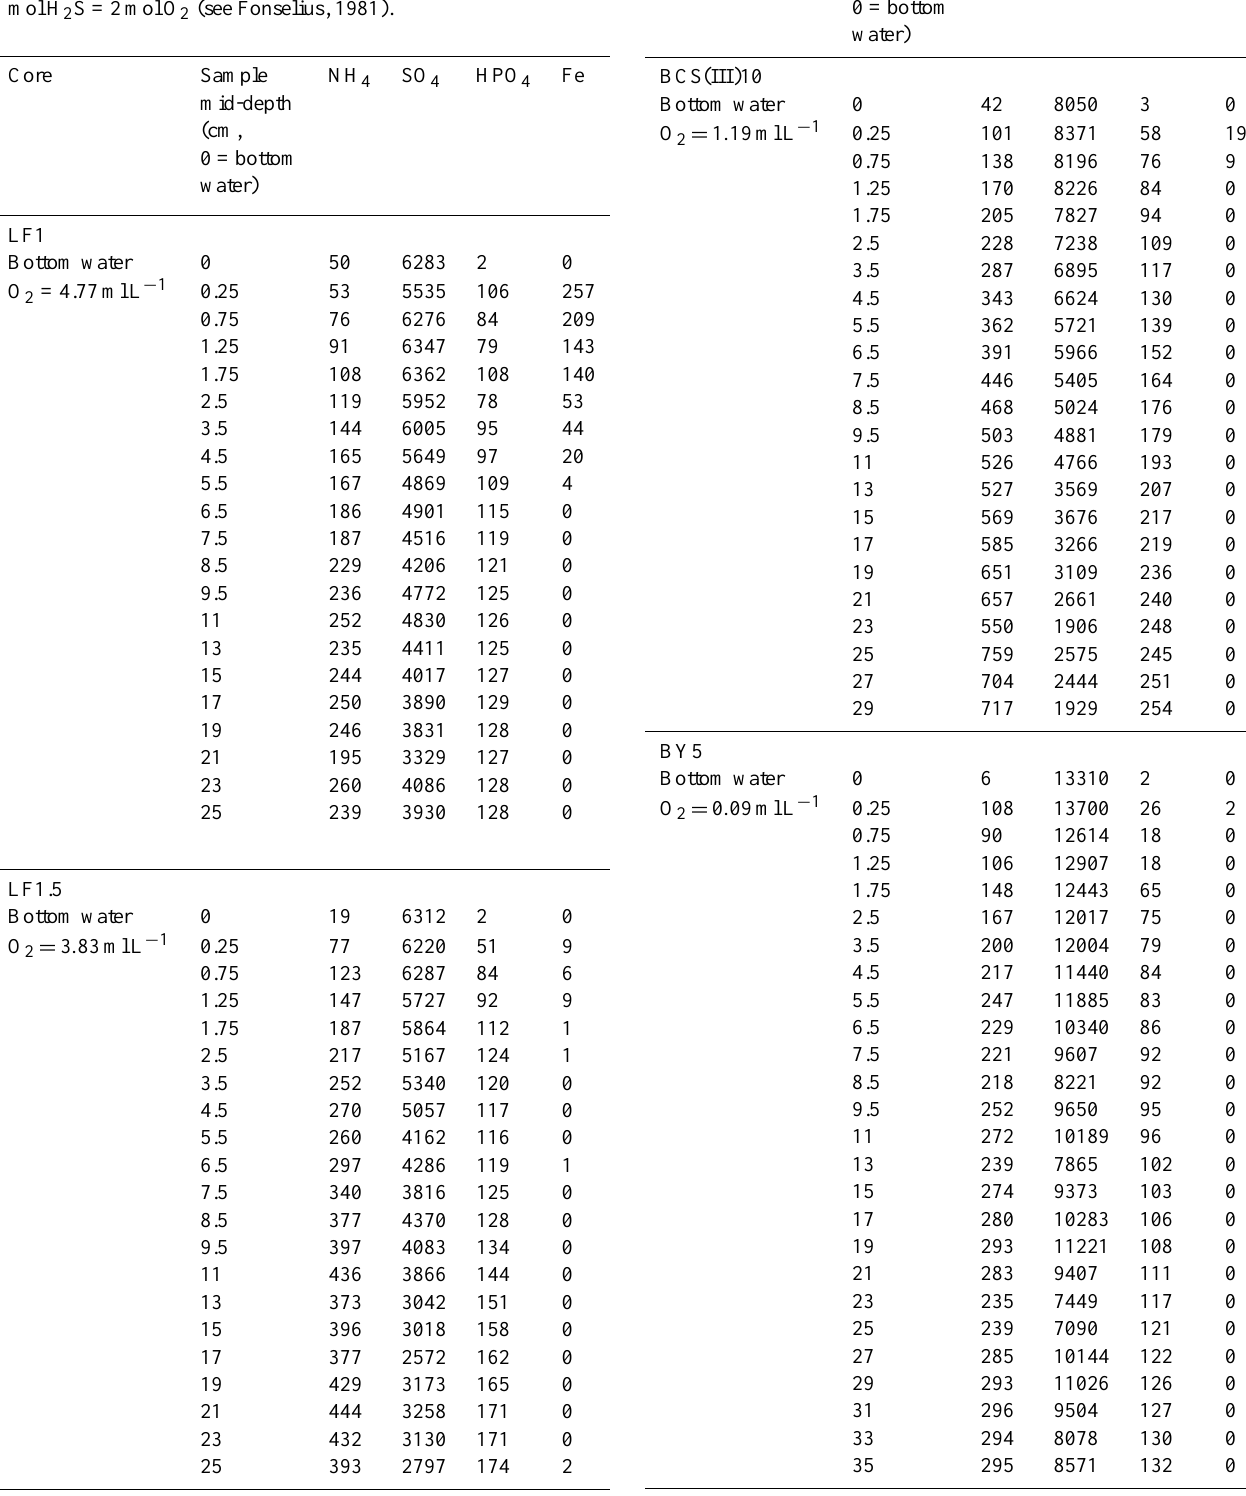
Table A1. Concentrations of porewater species in µmolL − 1 (R = sampled with rhizons) and bottom water oxygen concen- trations in mlL − 1 . Sub-zero oxygen concentrations are es- timated from hydrogen sulfide concentrations using the ratio 1molH 2 S = 2molO 2 (see Fonselius, 1981).